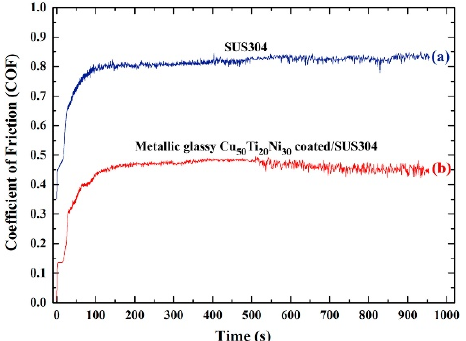
Figure 10. Dynamic COF(coefficient of friction) curves of ( a ) uncoated SUS304 substrate, and ( b )